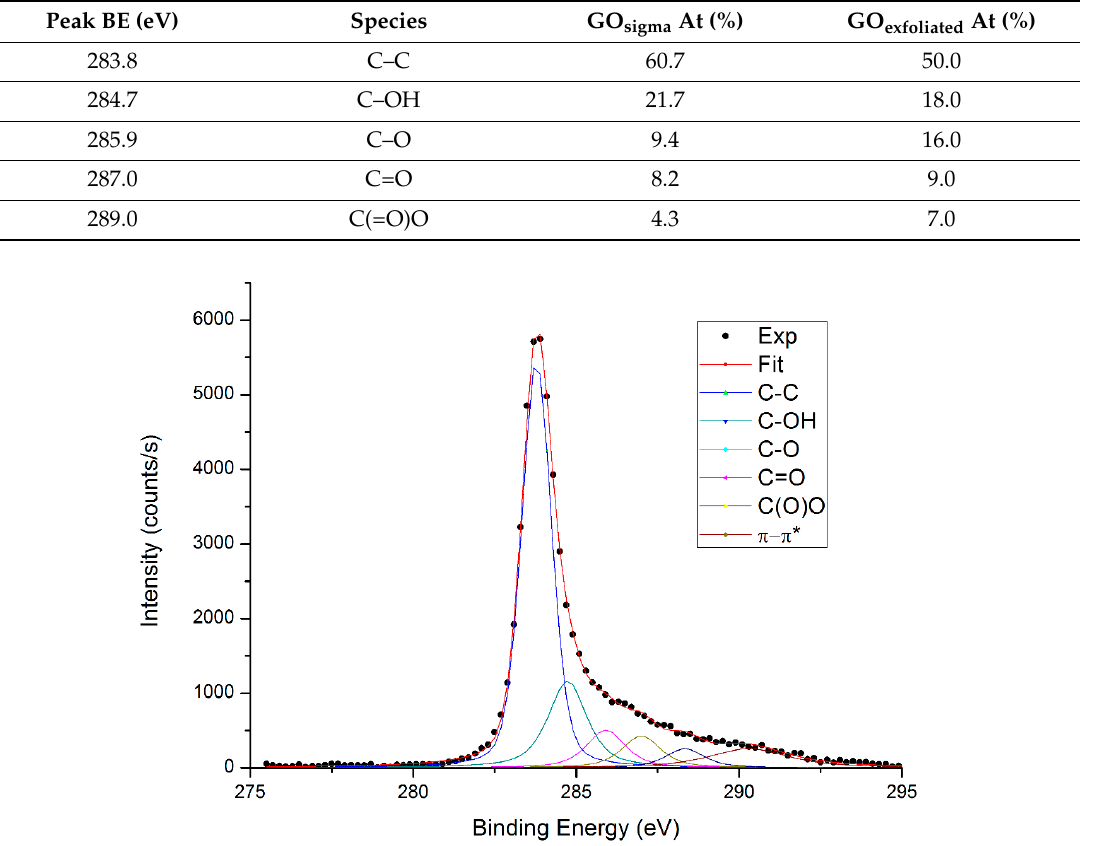
Figure 3. X-ray Photoelectron Spectroscopy (XPS) C1s spectrum of GO sigma .